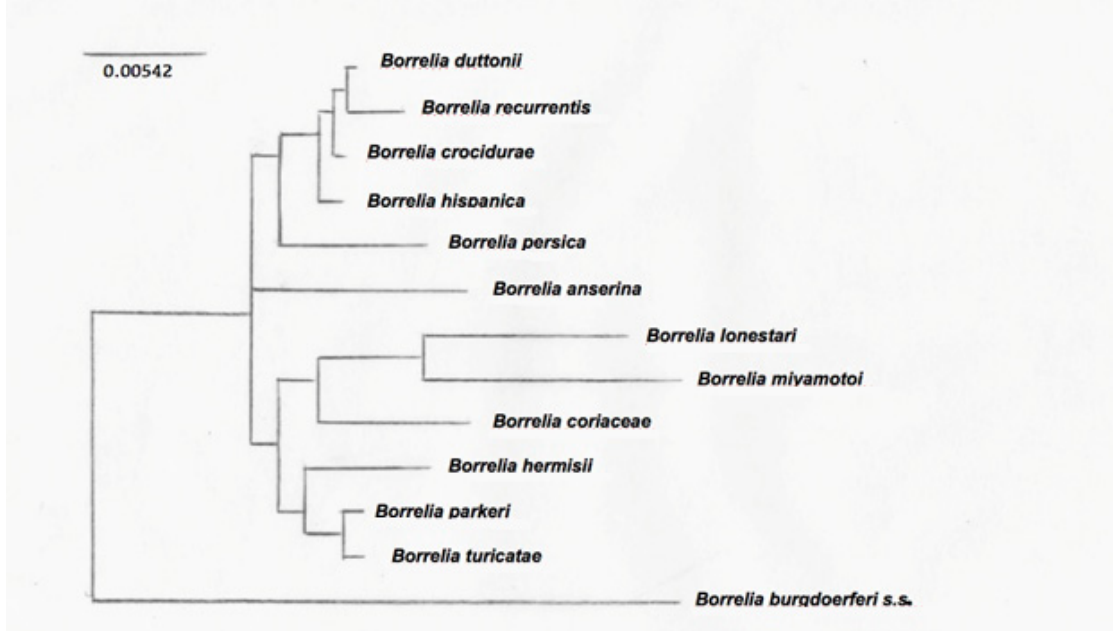
Figure 1. Phylogenetic tree based on the 16SrRNA sequences of the main RF Borrelia species. The 50% majority rule consensus tree based on 12 trees was obtained by using a maximum parsimony method